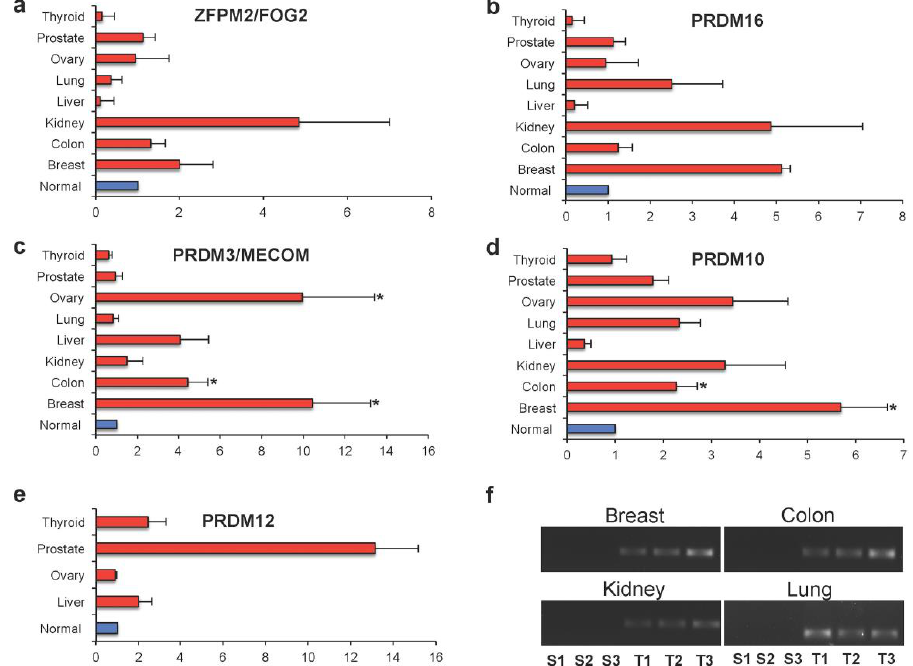
Figure 6. Relative expressions obtained by real-time PCR in different types of cancer tissues versus corresponding normal tissues (with arbitrary expression value equal to 1). The comparative threshold cycle (Ct) method was used with β -actin as the internal control. The results are expressed as the mean ± ES. The statistical significance of differences between experimental groups was calculated using the unpaired two-tailed Student’s t -test. (*) Results with a p -value < 0.05 were considered significant. ( a ) ZFPM2/FOG2 ; ( b ) PRDM16 ; ( c ) PRDM3/MECOM ; ( d ) PRDM10 ; ( e ) PRDM12 . ( f ) Representative samples analyzed for PRDM12 by agarose gel electrophoresis.